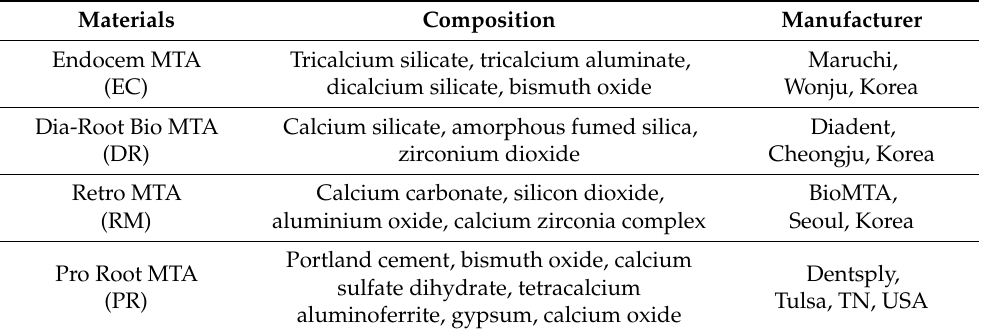
Table 1. Information on the four commercially available mineral trioxide aggregates (MTAs) used in the present